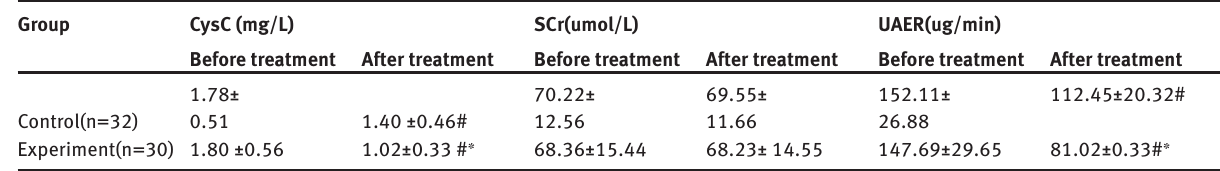
Table 2: The serum level of CysC, UAER, SCr before and after treatment for both control and experiment group Group After treatment Before treatment After treatment Before treatment After treatment